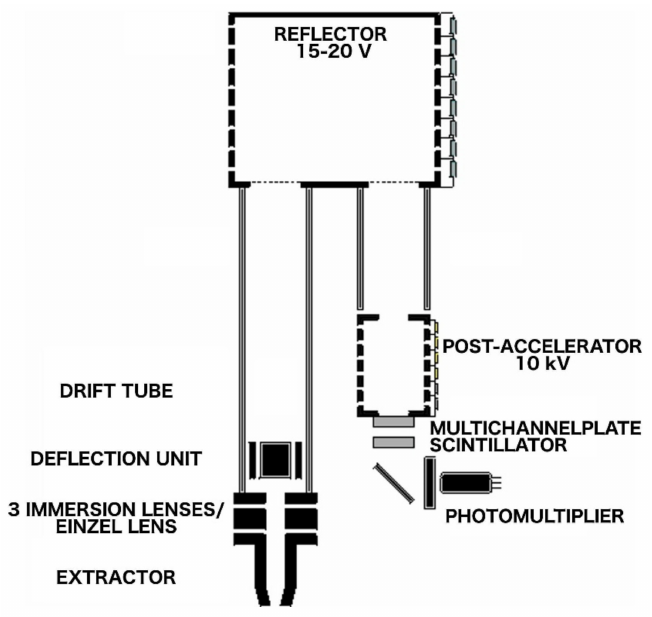
Figure 16. Schematic layout of the ToF analyzer with reflectron ion mirror at the LASR3 Surface Laboratory Roma